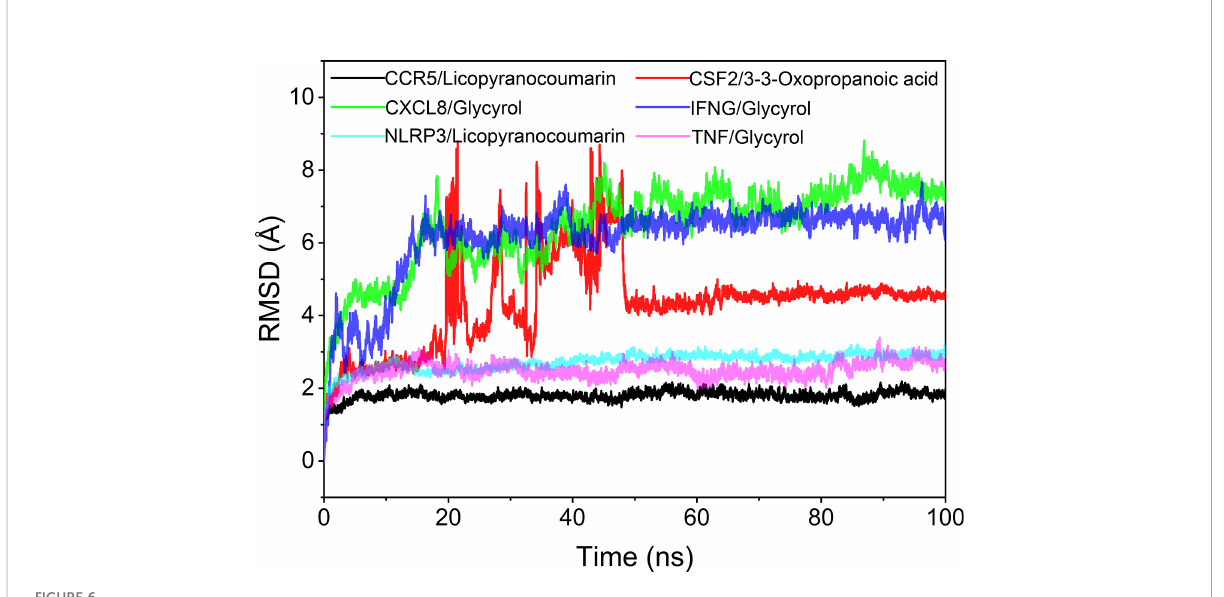
FIGURE 6 The result of root mean square deviation (RMSD).